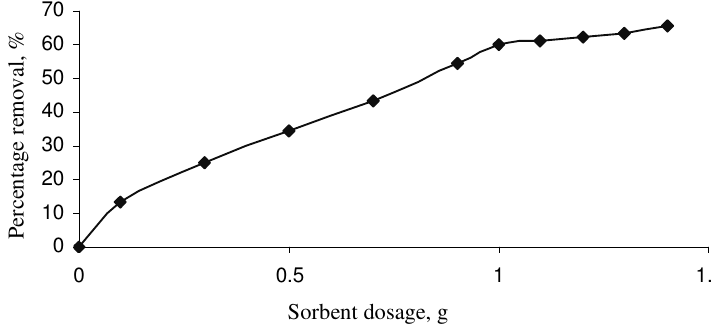
Figure 1 . Effect of adsorption (%) of the dye Grey BL on different amounts of the adsorbent, Derris leaf powder at 300 K (dye concentration 100 mg/L)